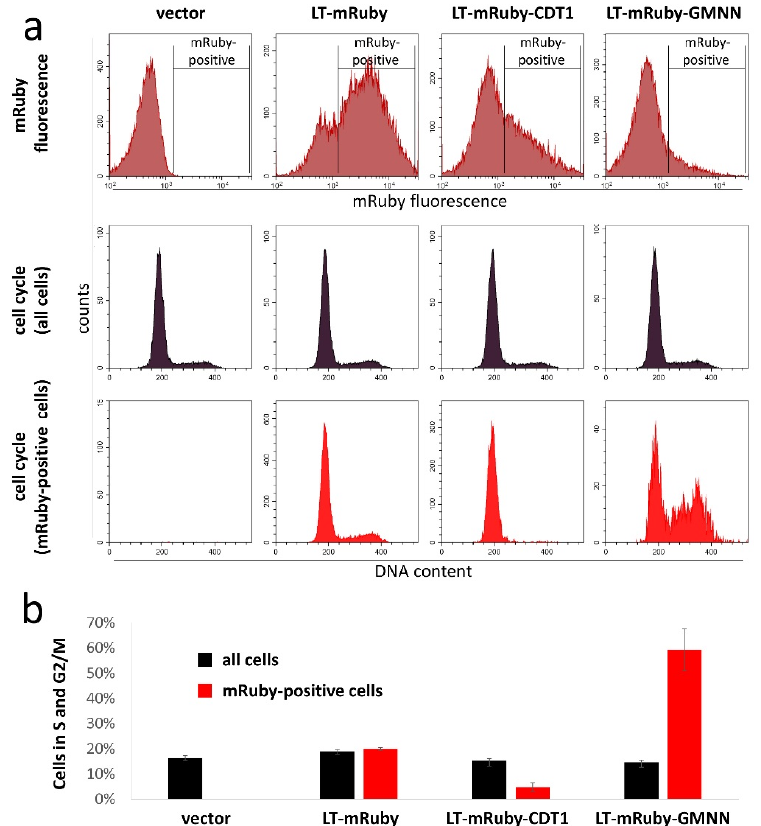
Figure 2. LT-mRuby-CDT1 is largely lacking in S and G2/M phases of the cell cycle in MKL-1 cells. MKL-1 TA.shRNA.tet cells were transduced with retroviral pIH vectors coding for the different indicated LT fusion proteins. Using Vybrant™ DyeCycle Violet, the DNA of viable cells was stained, and combined analyses of the DNA stain and mRuby fluorescence was performed by flow cytometry. ( a ) mRuby fluorescence is depicted in the upper, the cell cycle distribution of all cells in the middle, and of only mRuby-positive cells in the lower row. ( b ) The percentages of cells in S and G2/M phases of the total population and of only mRuby-positive cells are depicted as bar graphs (mean values (±SD) of at least three measurements). Since the MKL-1 cells were also stably transduced with TA.shRNA.tet, which is a vector allowing doxycycline (Dox)-inducible expression of an shRNA targeting all MCPyV-T antigen mRNAs, the ectopic expression of the fusion proteins allowed us to study their biological activity in MCC cells. This was possible since the TA.shRNA binding site was destroyed by six silent mutations in the coding sequence of the ectopically expressed LT variants. Dox-induced knockdown of endogenous LT as well as expression of the ectopically expressed LT variants was monitored by an immunoblot (Figure 3a). Notably, the weaker band for LT-mRuby-GMNN—compared to LT-mRuby or LT-mRuby-CDT1—is expected due to a smaller percentage of the total cell population being in S and G2, which are the cell cycle phases where the protein is stably expressed (Figure 2a). In contrast, analysis of mRNA expression levels reveals that all three fusions constructs are transcribed at a similar level (Supplementary Figure S1; primers given in Table S1). The impact on MCC cell proliferation of cell cycle phase-specific LT expression was then analyzed by flow cytometry in mixed cultures of green-fluorescent, double-infected cells and uninfected parental cells on the basis of GFP expression driven by the TA.shRNA.tet vector. To this end, Dox-induced knockdown of endogenous LT was associated with growth inhibition—evident by a gradual loss of GFP-positive cells over time—of TA.shRNA.tet cells additionally infected with an